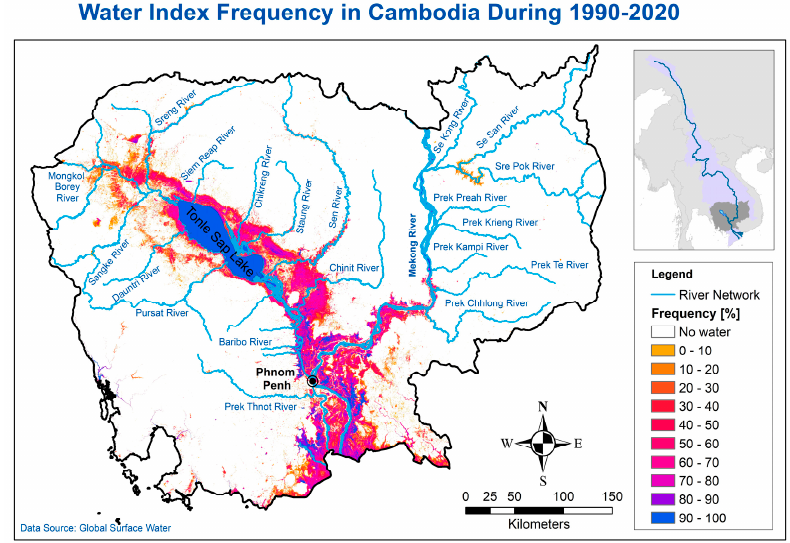
Figure 2. Water Index Frequency in Cambodia During 1990–2020.